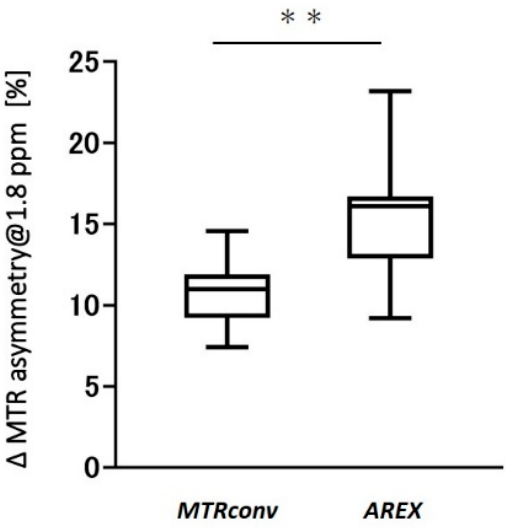
Figure 2. Difference in MTR asymmetry values between the testis and testicular epithelium at 1.8 ppm of MTR conv and AREX. ** p < 0.001. MTR, magnetization transfer ratio; MTR conv , conventional analysis metric magnetization transfer ratio; and AREX , apparent exchange-dependent relaxation.